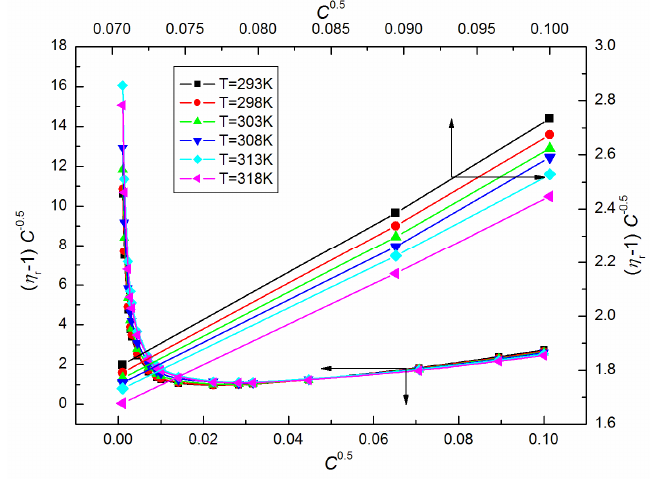
Figure 7. A plot of the values of ( η r − 1 ) C − 0.5 of the aqueous solutions of ELP at T = 293 K, 298 K, 303 K, 308 K, 313 K and 318 K vs. C 0.5 .